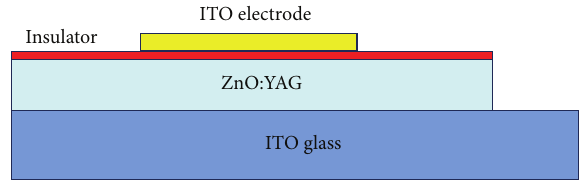
Figure 1: ITO/insulator/ZnO:YAG MIS structure on ITO/glass substrate.